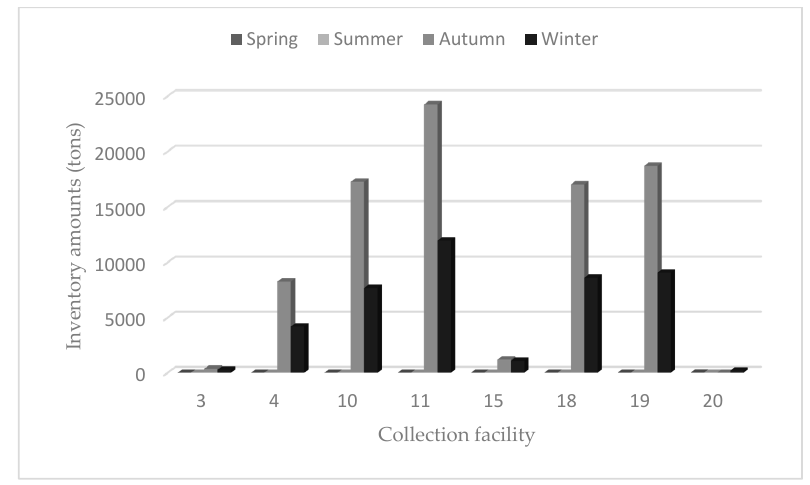
Figure 7. Feedstock amount from farmers.